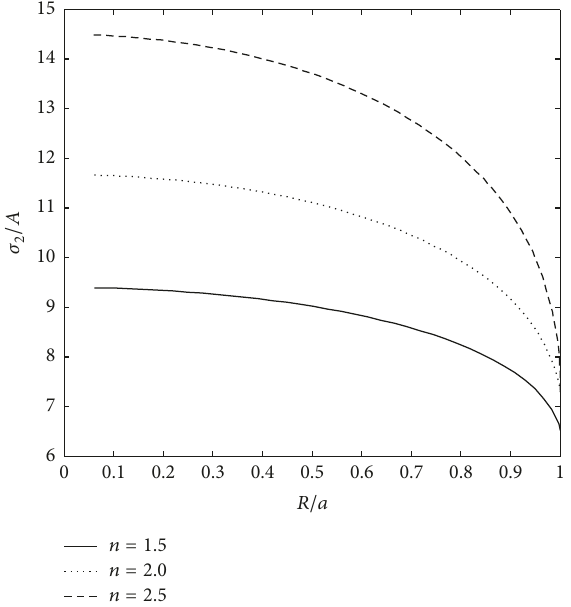
Figure 11: The circumferential stress distribution on membrane ( 𝑞/𝐴 = 10 ; 𝛼 = 0.6 ).